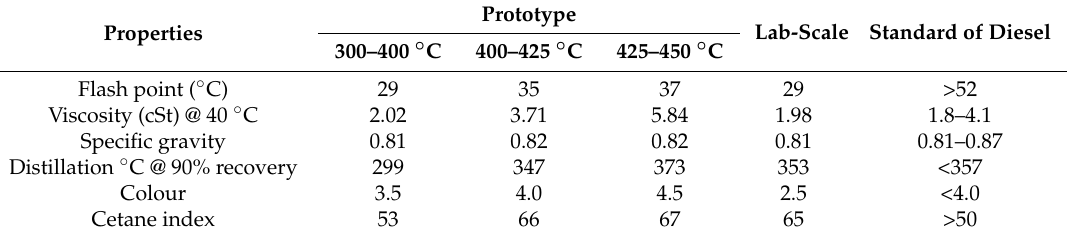
Table 4. Properties and product yields of the pyrolytic oil from the prototype (10 kg/day).